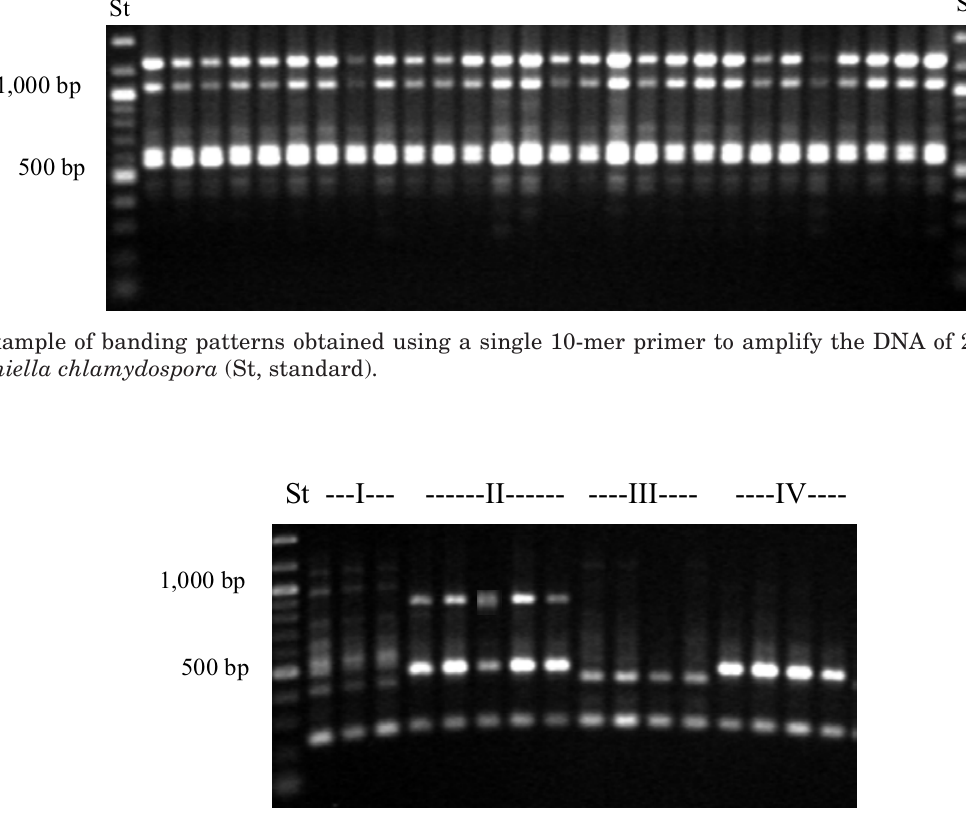
Fig. 2. Example of banding patterns obtained using a single 10-mer primer to amplify the DNA of isolates of Pho- mopsis viticola belonging to four different VCGs (St,